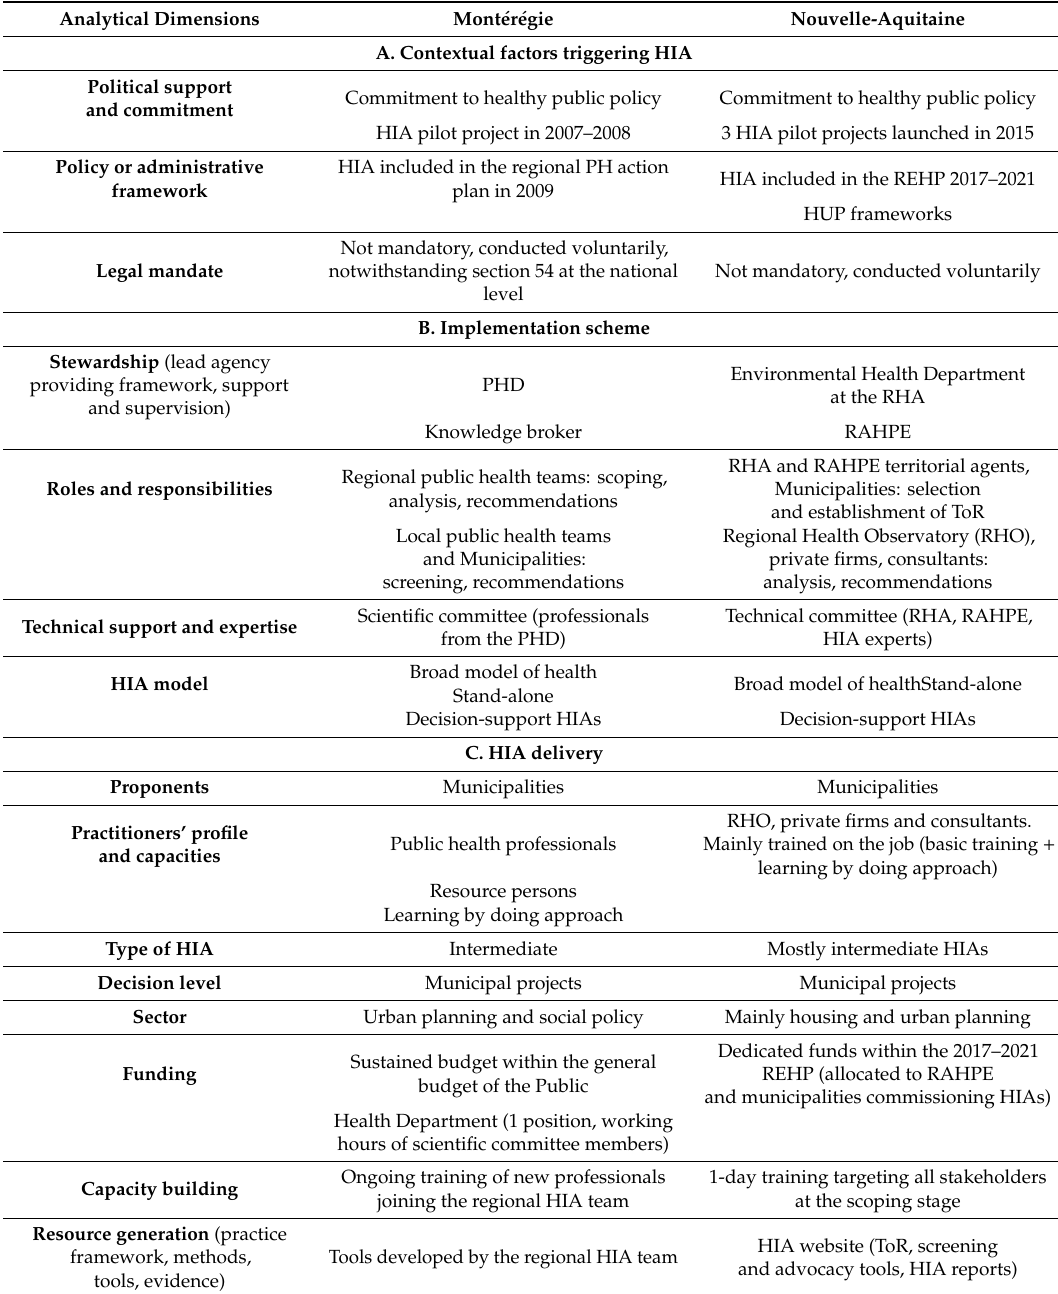
Table 1. Main features of the HIA implementation models in Mont é r é gie and